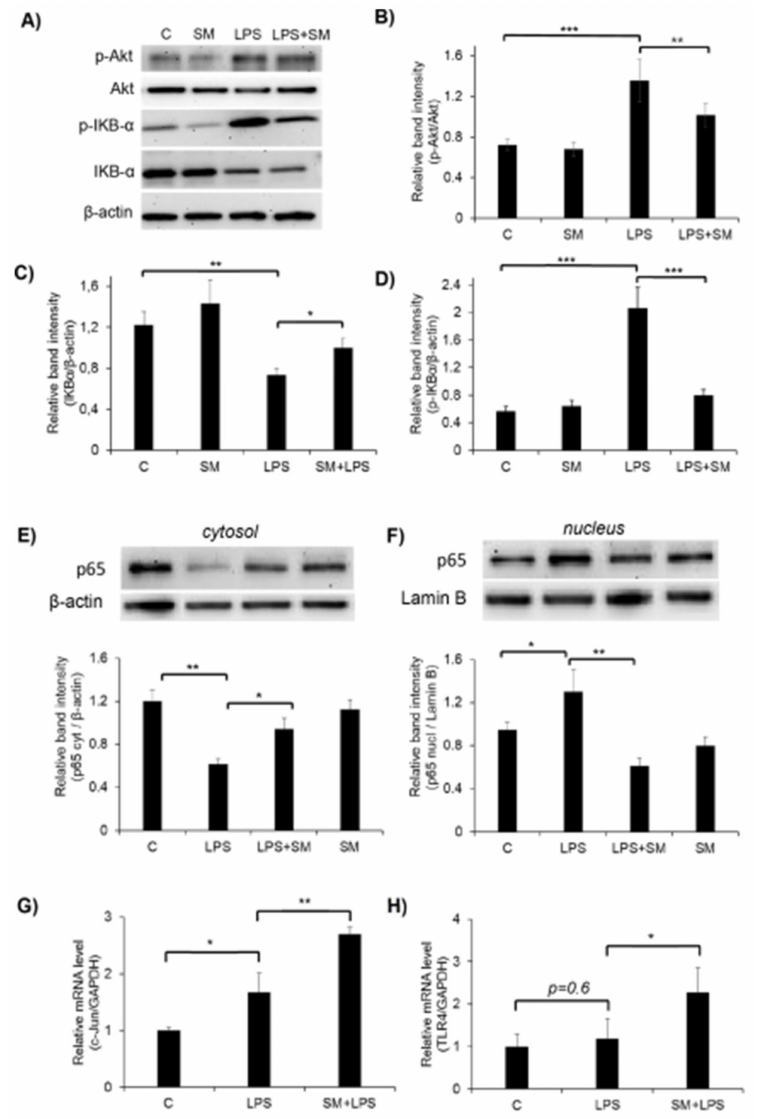
Figure 6. E ff ects of SM on the activation of Akt, nuclear factor- κ B (NF- κ B), AP-1 signaling pathway, and TLR4 in LPS-induced RAW264.7 cells. RAW264.7 cells were incubated with SM (0.5 µ M), LPS (1 µ g / mL), or SM + LPS for 6 h. Phosphorylation and total protein expression of Akt and IKB α were analyzed in whole cell lysates using Western blot. ( A ) Representative Western blot bands; the summarized bar graph shows band intensity presented as the ratio of pAkt to Akt ( B ), inhibitor of kappa B- α (I κ B- α ) to β -actin ( C ), and pI κ B α to β -actin ( D ). Cytoplasmic ( E ) and nuclear ( F ) fractions were prepared to analyze the nuclear translocation of p65. β -Actin was used as the loading control for the whole lysate and cytoplasmic fractions and lamin B1 were used for the nuclear fraction. c-Jun ( G ) and Toll-like receptor 4 (TLR4) ( H ) mRNA levels were analyzed by RT-qPCR. The data represent three independent experiments. In all experiments, untreated cells were used as the control (designated by C). * p < 0.05, ** p < 0.01, *** p <